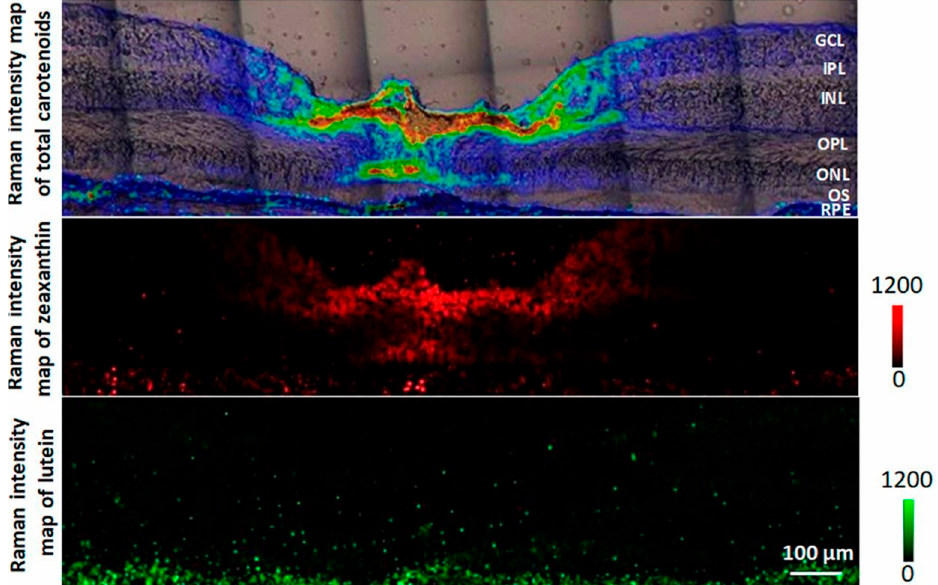
Figure 6. Raman intensity mapping showing the distribution of total macula carotenoids and individual macula carotenoids, zeaxanthin and lutein in a human retinal section (Reprinted with permission from Ref. [91]).